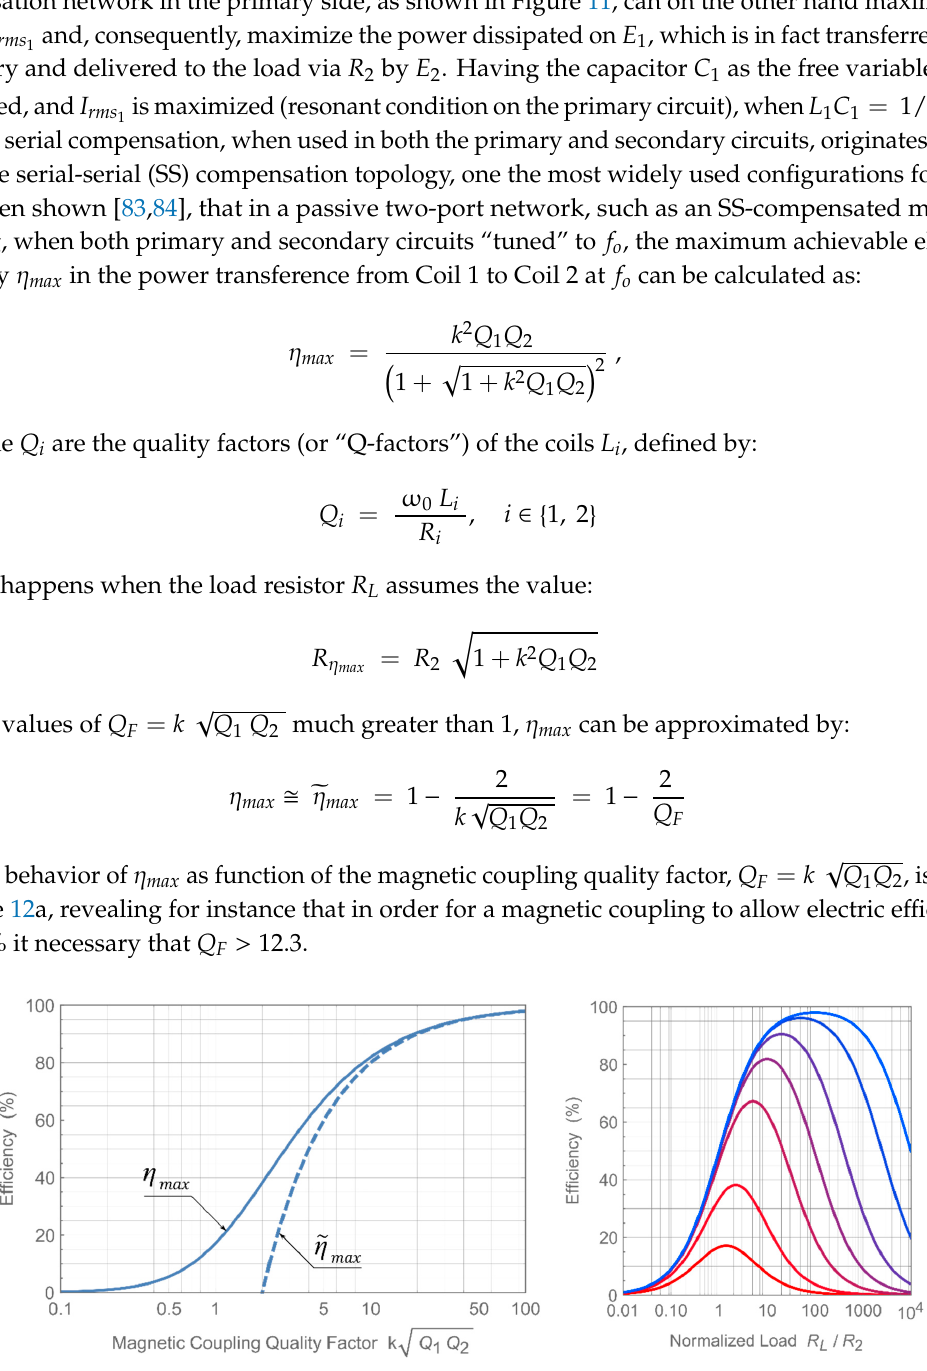
√ Q 1 Q 2 ; ( b ) e ffi ciency as a